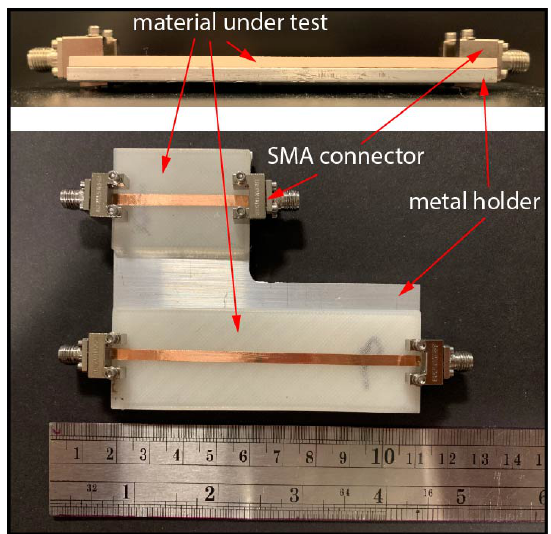
Figure 2. AM nylon substrates with SMA connectors on the test